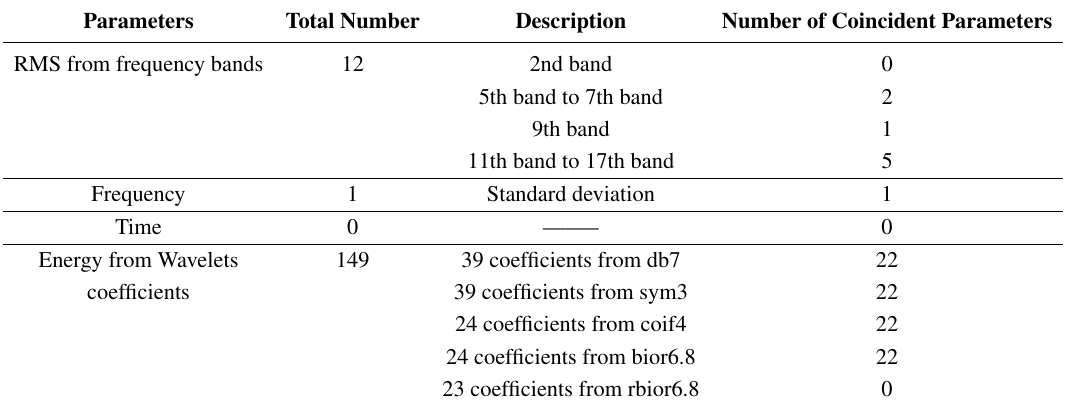
Table 8. Best 162 features selected by